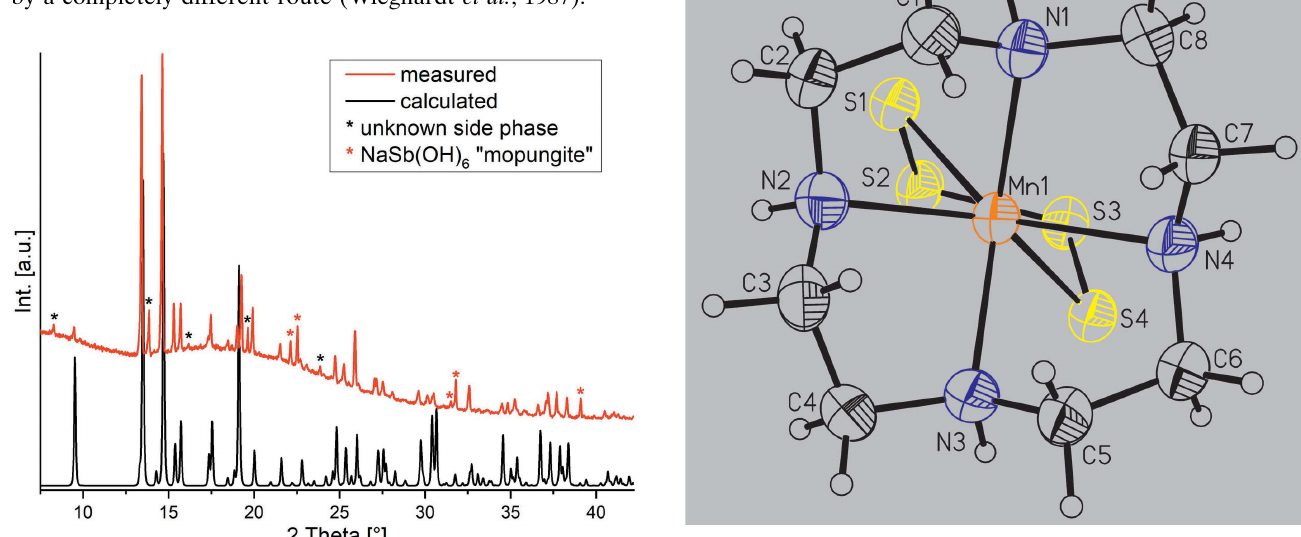
Figure 2 Molecular structure of the title compound with atom labelling and displacement ellipsoids drawn at the 50% probability level.